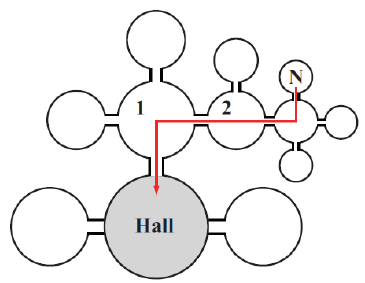
Figure 16. Pore network model to evaluate the mathematical form of the escape function. Republished from Xue et al. [11] with permission of The Electrochemical Society, conveyed through Copyright Clearance Center, Inc.